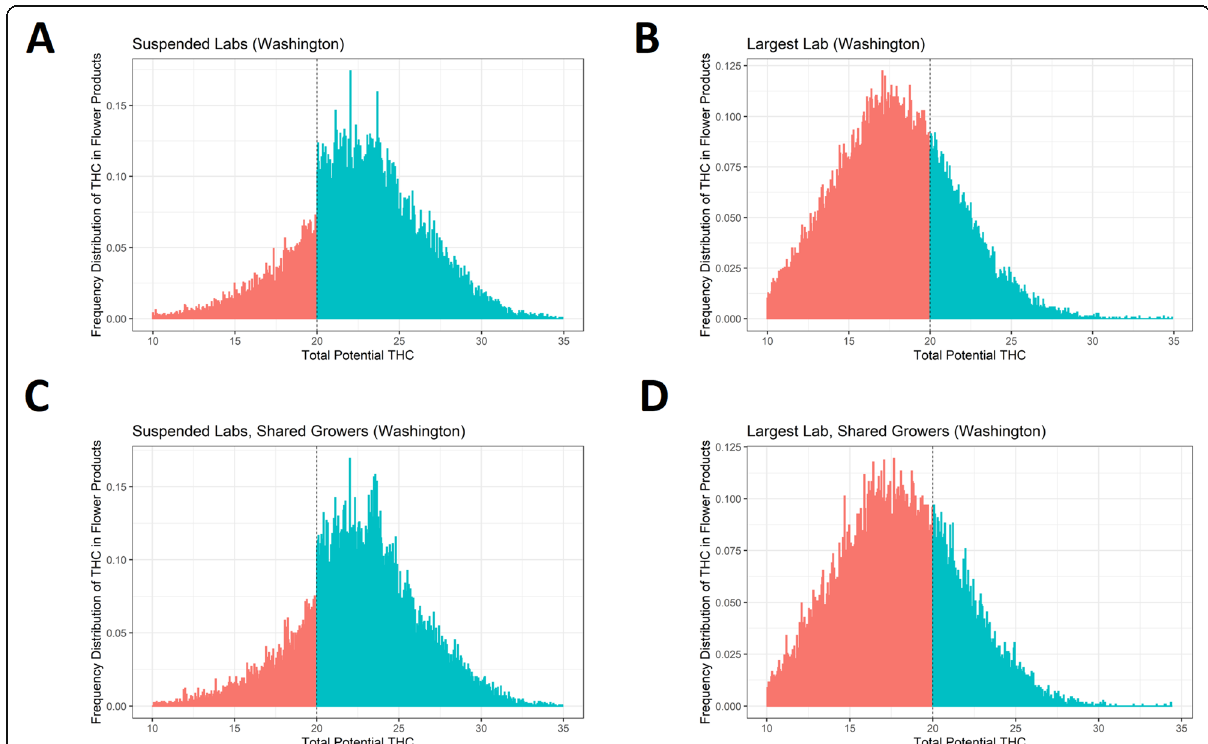
Fig. 2 Frequency of reported THC content around the 20% threshold among subsets of labs. This figure consists of four plots showing histograms of the frequency of reported THC, with bins to the left of the 20% threshold shaded red and bins to the right of the 20% threshold shaded blue. Plots are left-truncated at 10% for presentational purposes. The top left plot (panel a ) shows data from two labs in Washington state which had their licenses suspended ( “ suspended labs ” ), and the top right plot (panel b ) shows data from the lab in Washington which tested the most products during the study period ( “ largest lab ” ). The bottom row also plots histograms from the suspended labs (left; panel c ) and the largest lab (right; panel d ) but only using testing data from those growers which sent products to both sets of labs. While the two suspended labs show sharp increases in frequency at the 20% threshold (panels a and c ), the frequency distribution for the largest lab is smooth across the 20% THC threshold (panels b and d ). Histogram bins were generated via the DCdensity